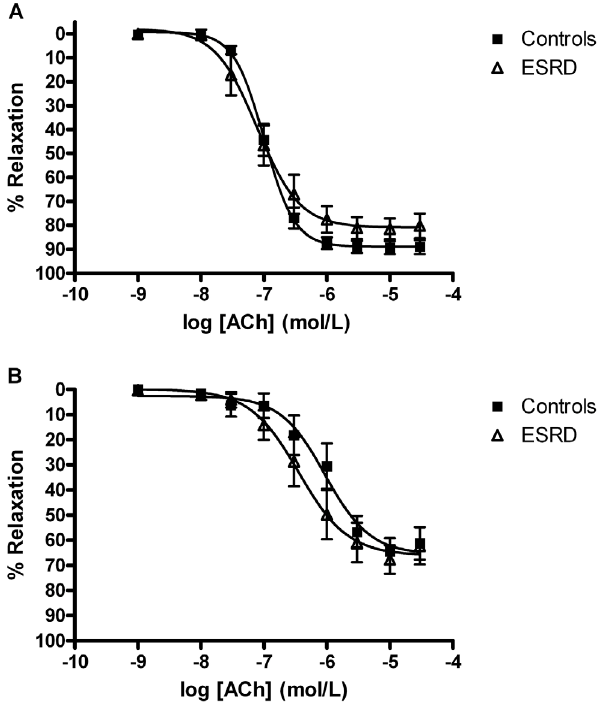
Figure 1. Concentration-response relaxation curves to acetyl- choline in arteries from healthy controls and patients with end stage renal disease. A: Endothelium dependent vasodilatation; p=ns. B: Endothelium-derived hyperpolarisation-like relaxation in the presence of indomethacin and L-NAME; p=ns.